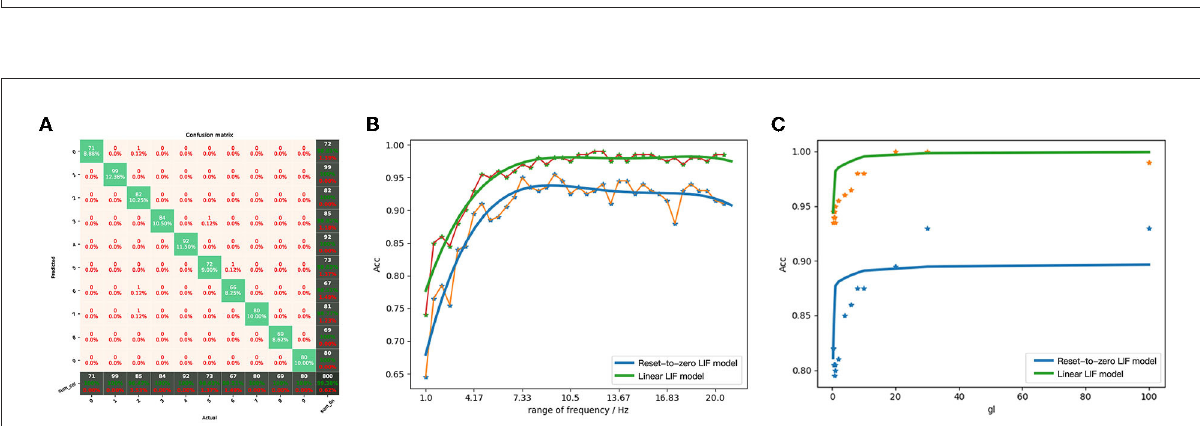
FIGURE13 (A) The confusion matrix between the output of the network built by LIF/SNN and the predicted value of ReLU/DNN. (B) Comparison of classification accuracy of MNIST between LIFNN and LIFNN by changing the range of coding frequency. (C) Comparison of classification accuracy of MNIST between LIFNN and LIFNN by changing membrane